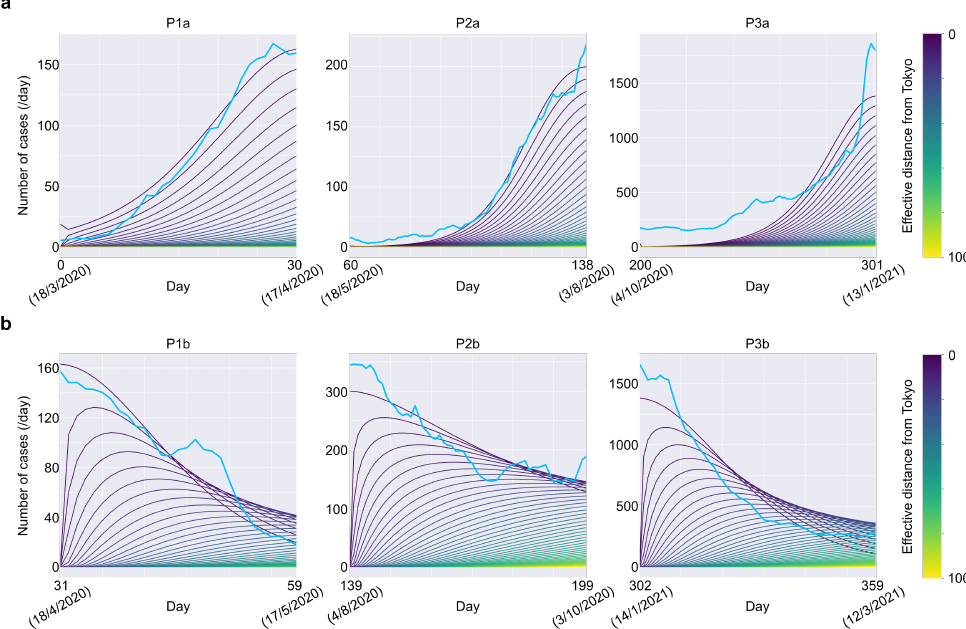
Figure 2. Effectivedistance from Tokyo is estimated from the diffusion process. ( a , b ) Solutions of diffusion equations for each period ( a ): before peaks of infection, ( b ): after peaks of infection. Solutions for x ∈ { 2 n | 0 ≤ n ≤ 50, n ∈ Z } over time are shown. The source of the diffusion process ( x = 0) is the solution of the SEIR model, whose parameters were calibrated based on the MCMC algorithm (Figure